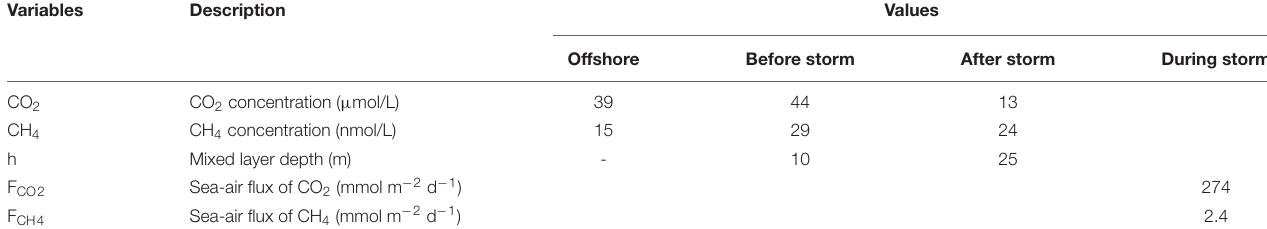
TABLE 1 | Concentrations, fluxes and mixed layer depths used in the box model calculations of CO 2 and CH 4 sources and sinks in TZS coastal waters during the storm event 21–23 September 2018. Variables Description